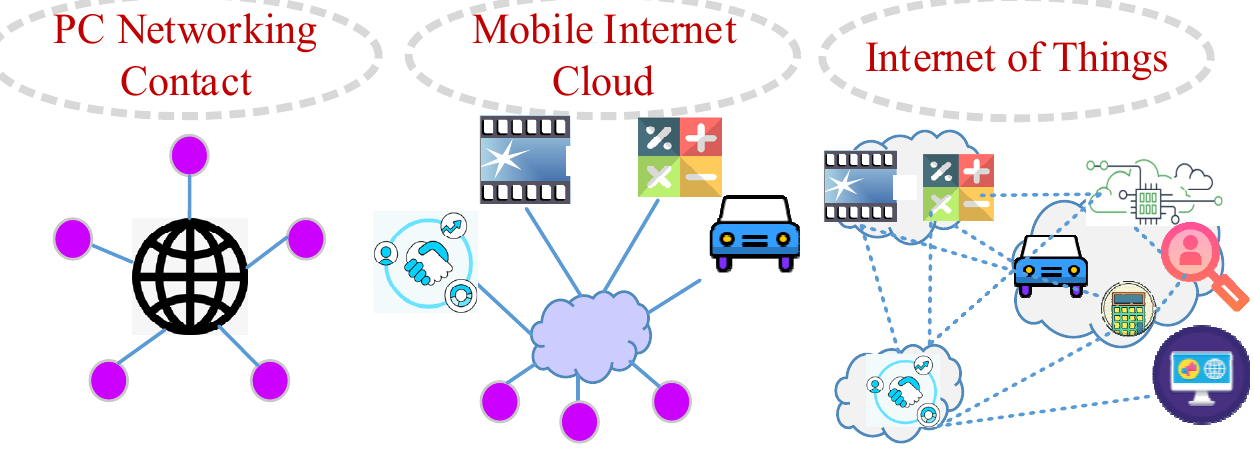
Figure 2. Pattern change from PC internet to IoT.